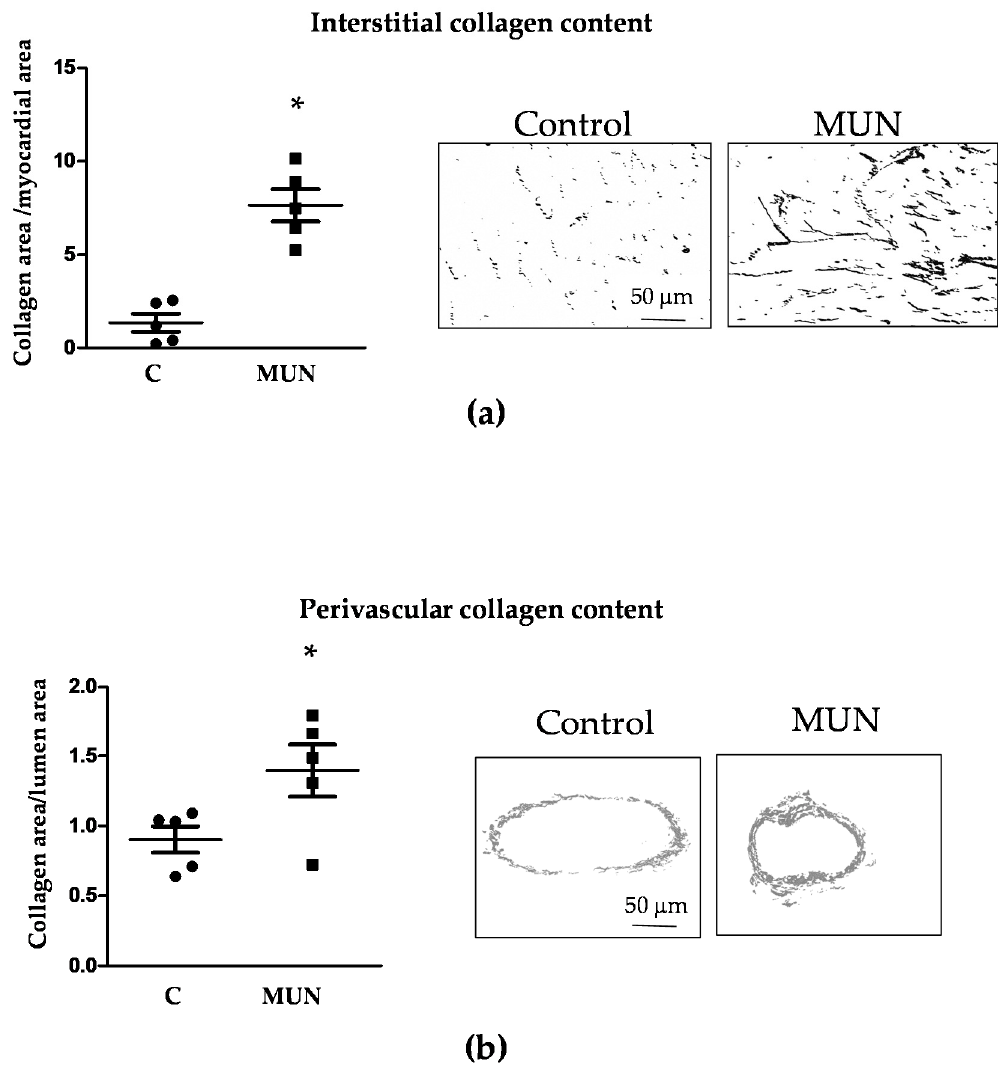
Figure 3. Heart collagen content in 21-day old male offspring from rats exposed to maternal undernutrition during preg- nancy (MUN) and control rats fed ad libitum (C). ( a ) Interstitial collagen and representative binary images; ( b ) perivascular intramyocardial artery collagen and representative binary images. Heart sections were stained with Sirius red; images were obtained at ×10 (myocardium) or ×40 objective (intramyocardial arteries) and transformed in binary images for quan- tification. Left panels show quantitative analysis of the relative area occupied by collagen. Sample size per group: 7 rats from 5 litters. Student’s t test, * p < 0.05 compared to C rats.